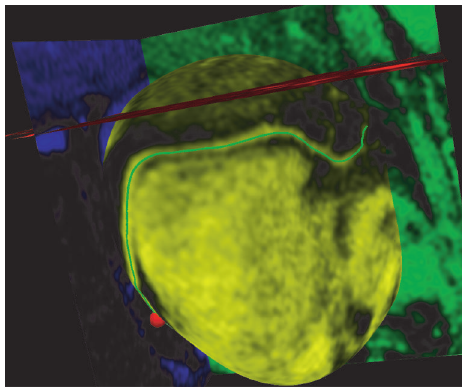
Figure 5: Spherical reformation with superimposed vessel center-